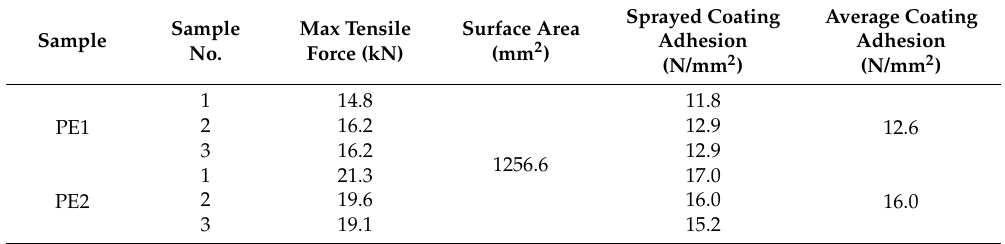
Table 6. Summary of results obtained during the static tensile test of arc sprayed coatings.